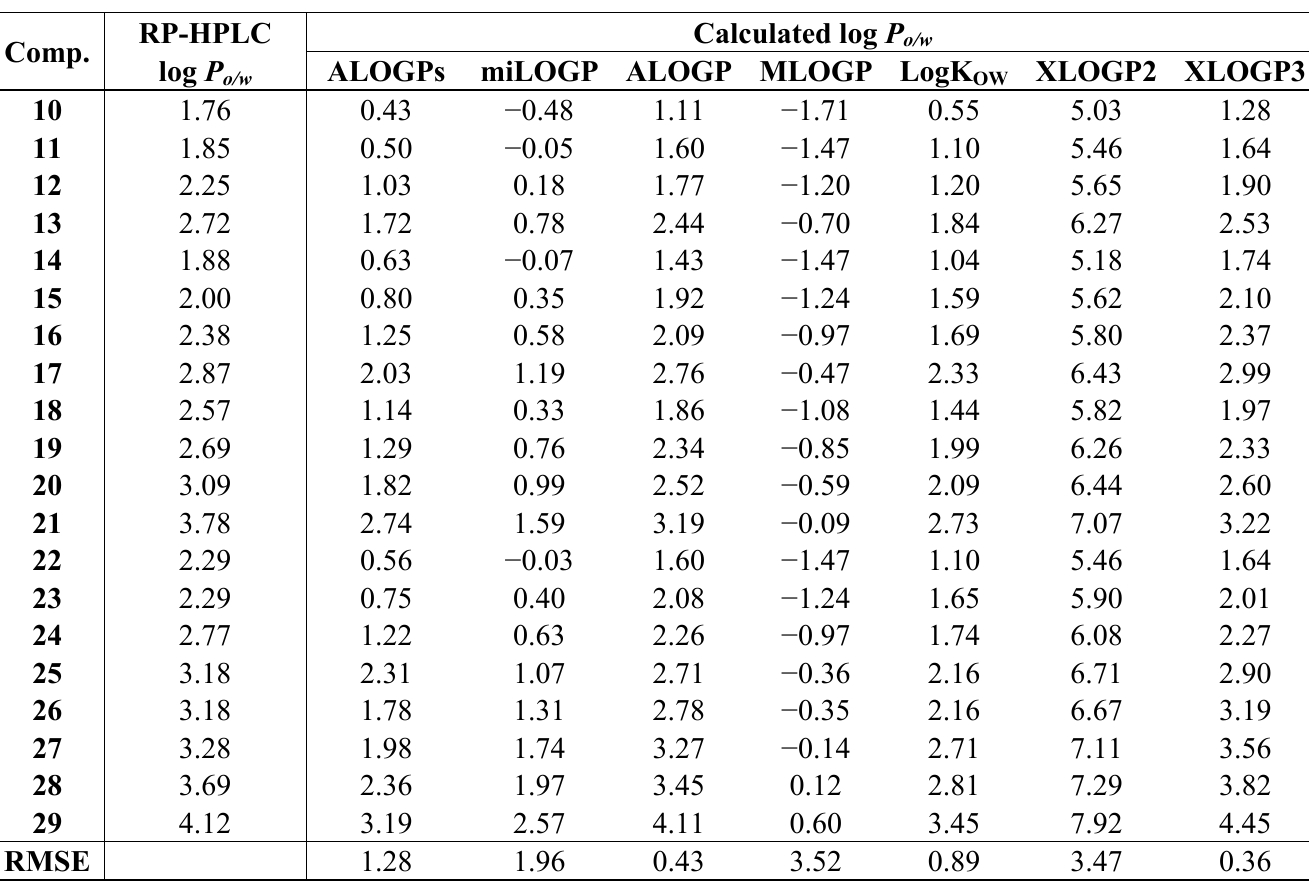
for quinoxaline derivatives and related o/w